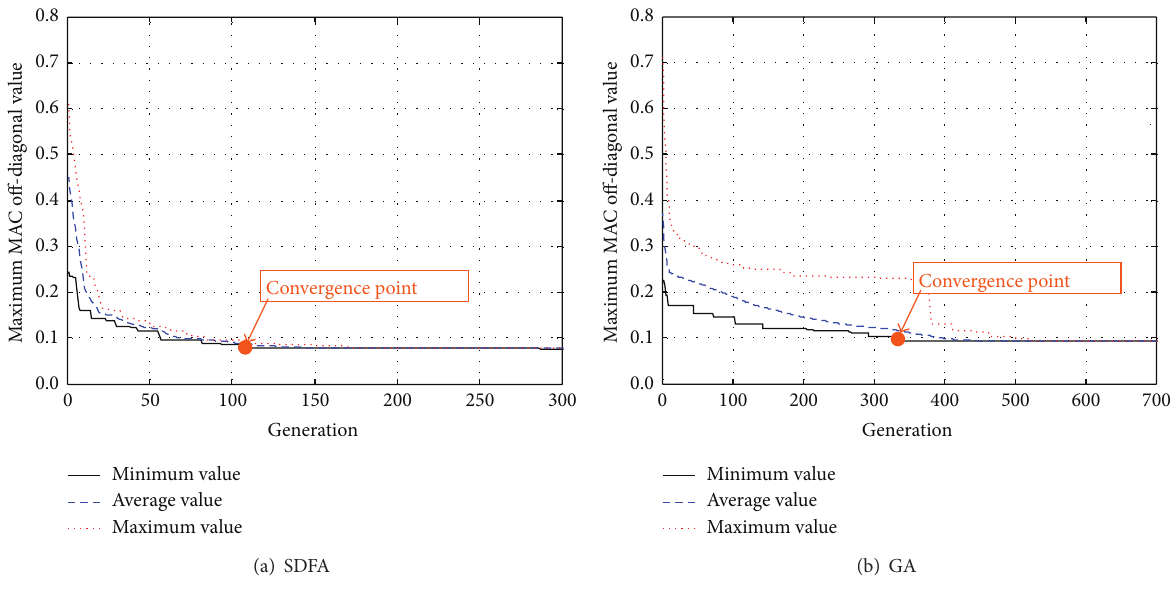
Figure 5: Iteration progress of the objective